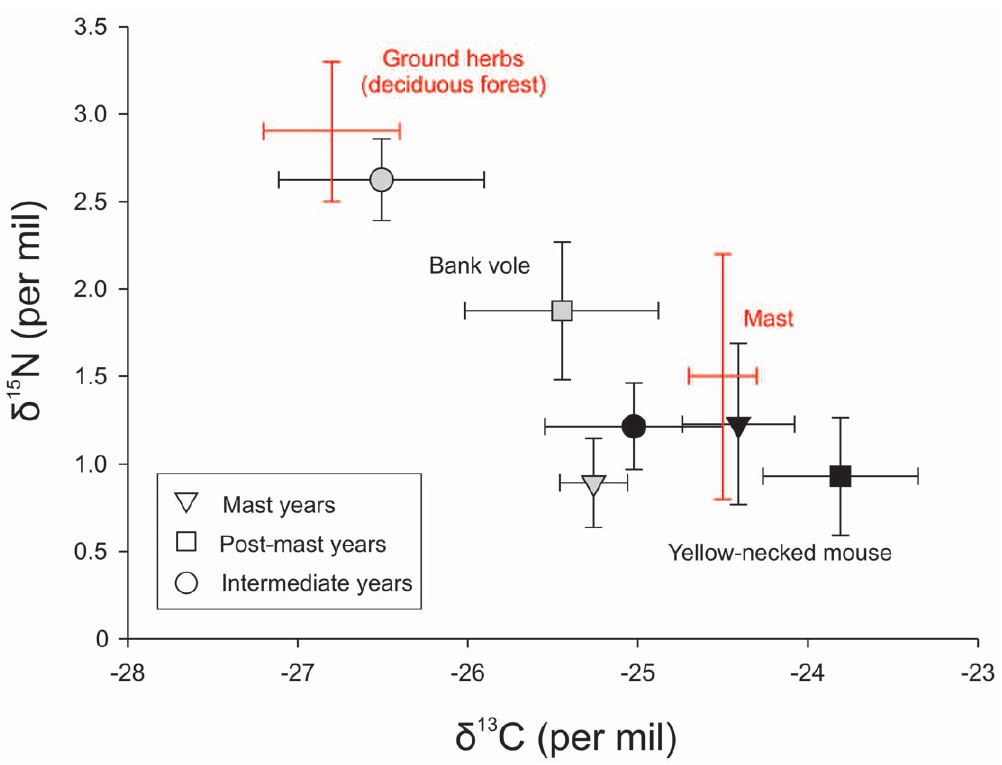
Figure 2. Isotope values of the rodent species along mast cycles. Mean ( 6 S.E.) d 15 N and d 13 C values for bank voles (grey symbols) and yellow-necked mice (black symbols) in mast, post-mast and intermediate years. Also shown are positions animals would occupy if they had exclusive diets of deciduous forest herb vegetation and mast seeds (oak, hornbeam, lime, spruce).